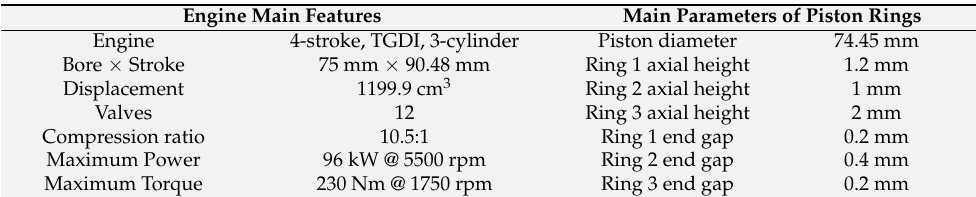
Table 1. Engine main features.